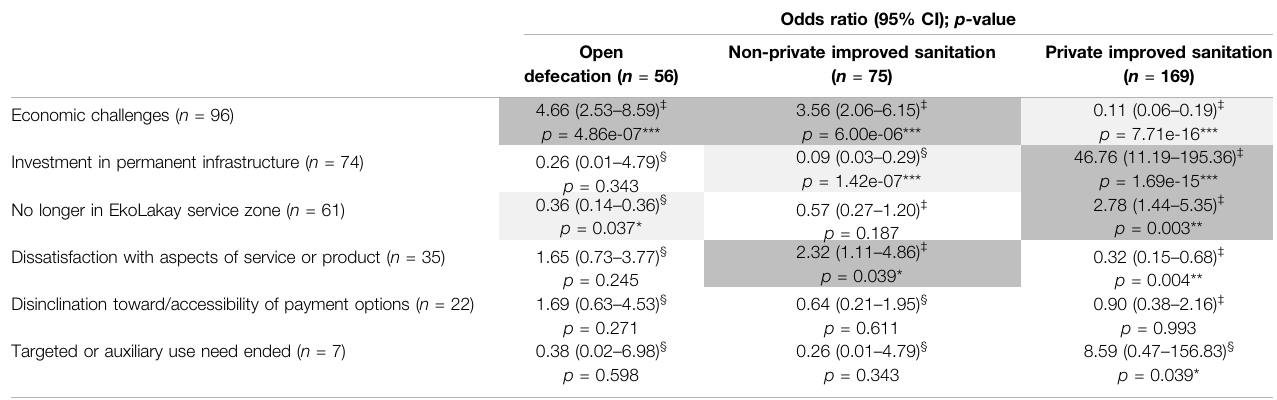
TABLE 5 | Former subscribers ’ household sanitation upon leaving, by reported factors affecting subscription termination ( n (cid:1)